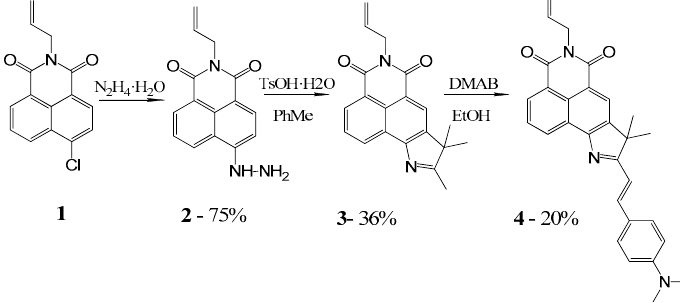
Figure 2. General scheme of 5-allyl-9-(4-(dimethylamino)styryl)-8,8-dimethylbenzo[de]pyrrolo [2,3-